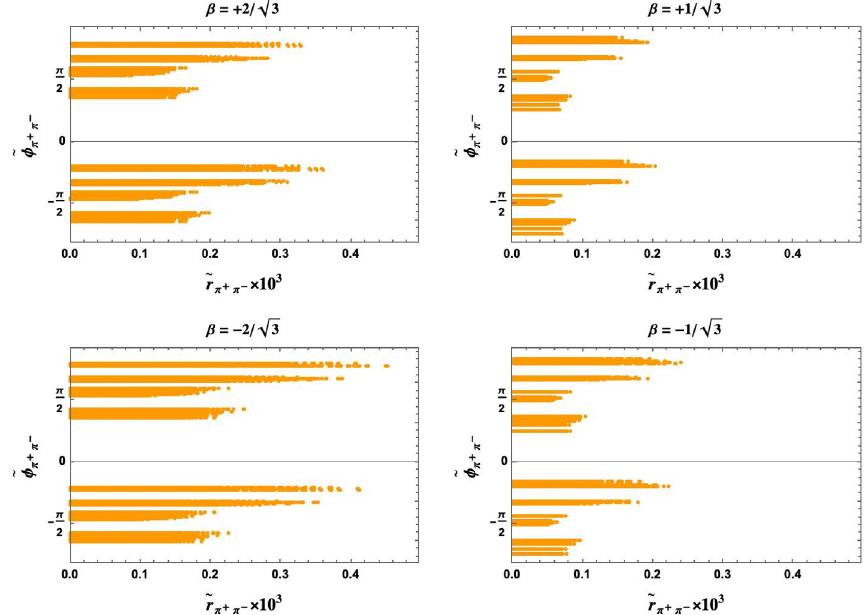
JHEP10(2021)021